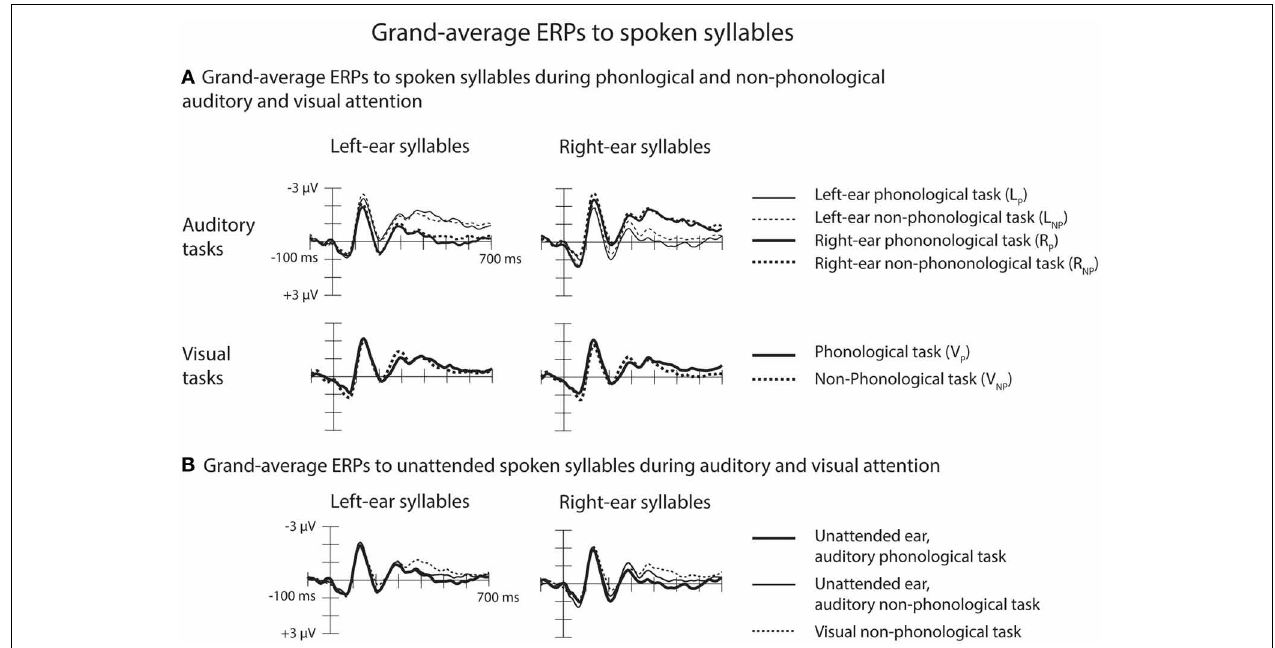
left-ear and right-ear standard syllables during visual phonological and non-phonological tasks (V P /solid lines and V NP /dotted lines, respectively). (B) Grand-average ERPs at Cz to unattended left-ear and right-ear standard syllables during phonological (thick solid lines) and non-phonological (thin solid lines) auditory tasks (data combined across the left-ear and right-ear tasks) and during the visual non-phonological task (dotted